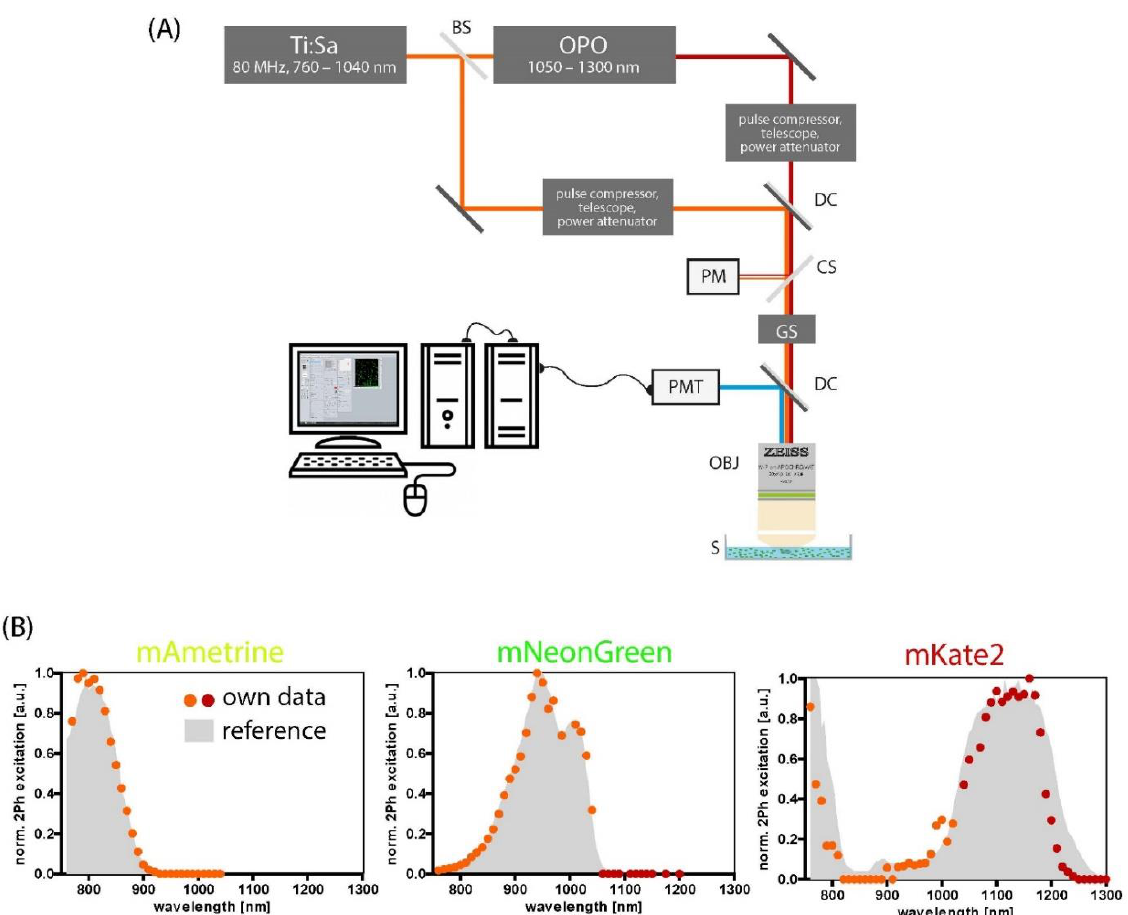
Figure 1. Acquisition and evaluation of two-photon excitation spectra of fluorescent proteins ex- pressed in the cytosol of transfected HEK-293T cells. ( A ) Experimental setup. The beam of a titanium sapphire laser (Ti:Sa) at 760–1040 nm passes a beam splitter (BS), one part of the laser beam pumps an optical parametric oscillator (OPO) to generate higher wavelengths (1060–1300 nm). Both Ti:Sa and OPO beams each travel through a beam shaper including a pulse compressor, a telescope, and a lambda half-plate for power attenuation and are combined by a dichroic mirror (DC). To monitor the excitation power, a cover slip (CS) is placed at 45 ◦ to the optical axis and reflects approx. 5% of